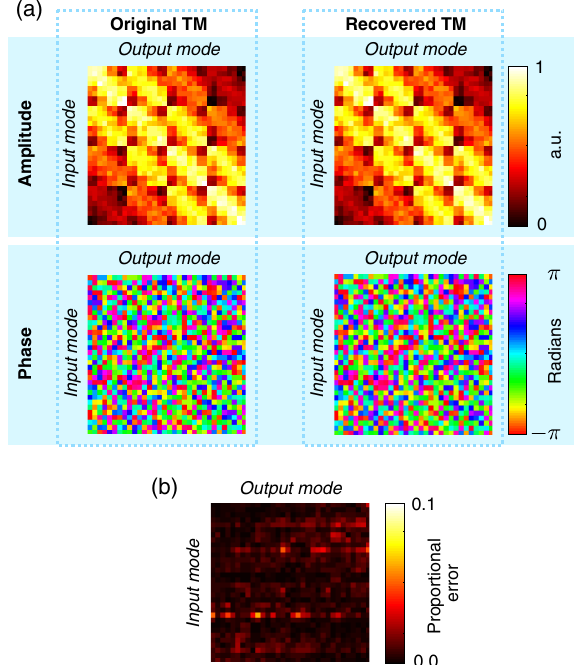
FIG. 4. Recovery of a simulated TM using the first-order recovery algorithm: (a) The original simulated TM is compared 10 − 3 ) demonstrating with the recovered TM (noise level σ n ¼ successful recovery. (b) Proportional elementwise error in TM reconstruction (maximum less than 0.05) after 300 iterations of first-order